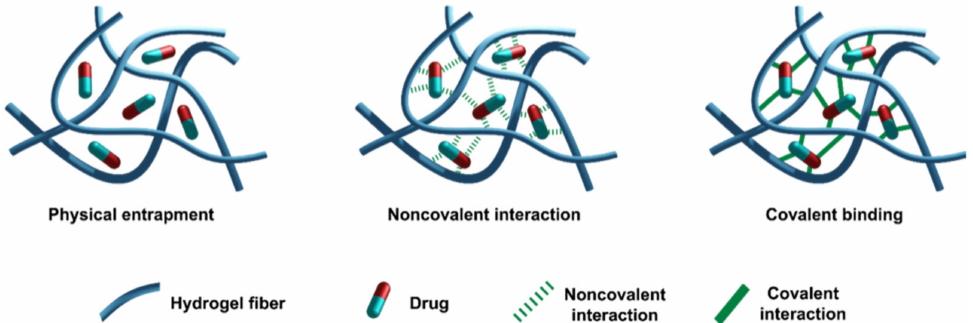
Figure 4. Different modes for drug